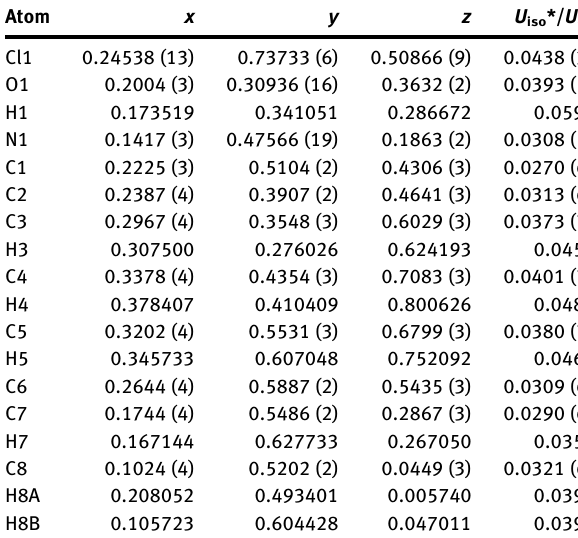
Table  : Fractional atomic coordinates and isotropic or equivalent isotropic displacement parameters (Å 